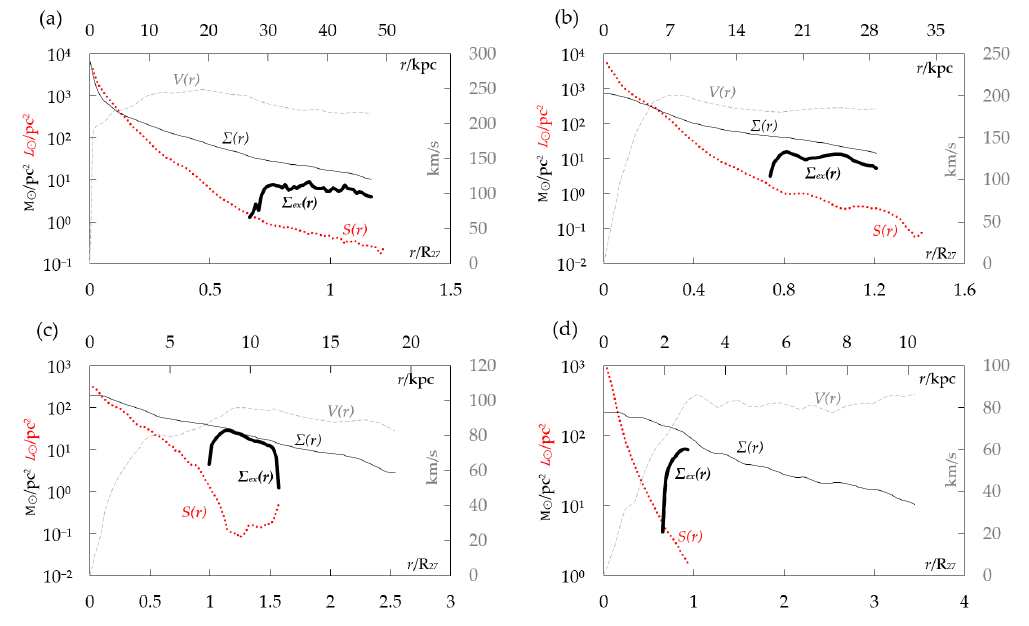
Figure 11. Representative cases for a subsample of 82 galaxies showing some excess density: ( a ) NGC5907; ( b ) NGC4157; ( c ) NGC0300; ( d ) NGC2915. Red and black thin curves represent surface brightness S(r) in L (cid:12) ,3.6 / pc 2 and surface mass density The Black thick curve is density excess above light-constrained stellar density side Y-axis ). The dashed grey curve is rotation curve V(r) in km / s ( right side Y-axis ). Lower X-axis is a galactocentric radius in units of r / R 27 . Upper X-axis is a galactocentric radius in units of r /